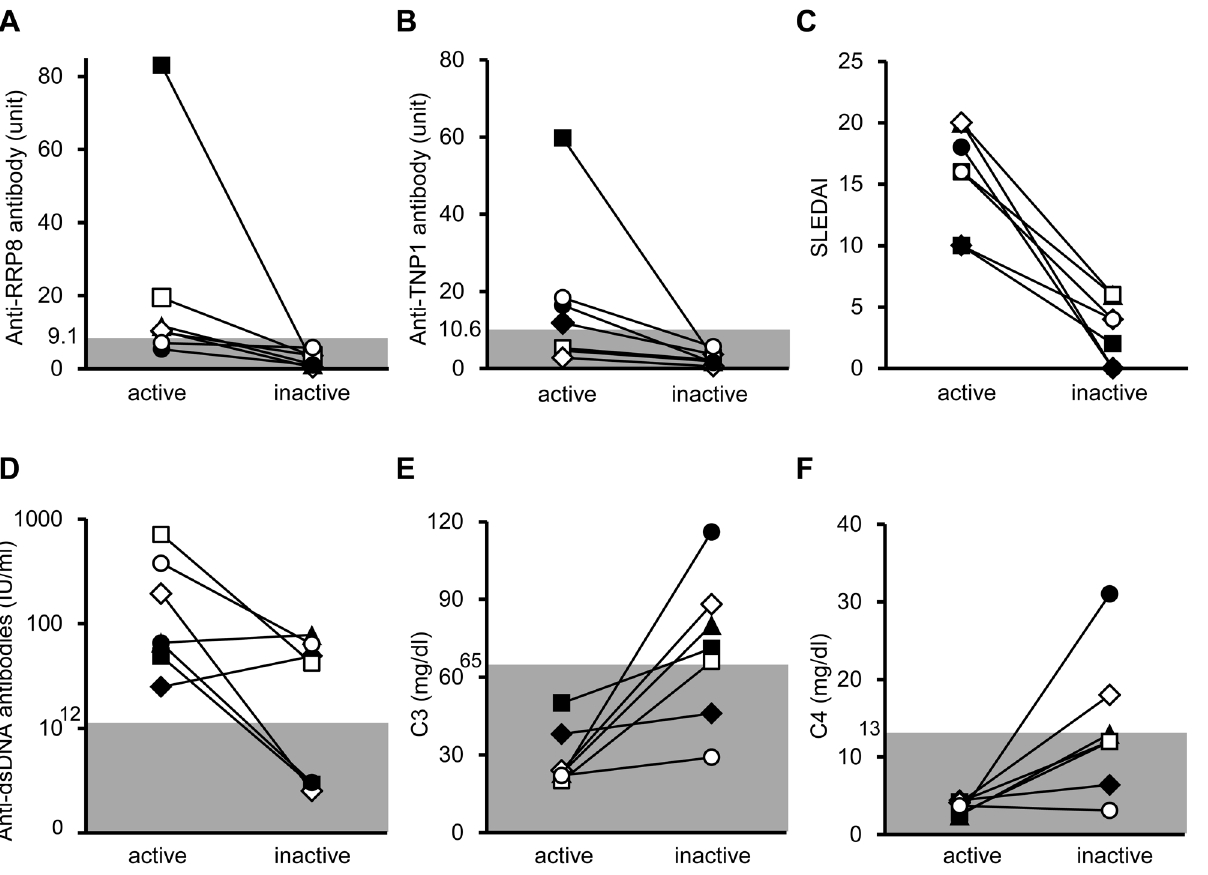
Fig 5. Changes in antibody levels and clinical findings in patients with lupus nephritis. ▲ LN1, ♦ LN2, ● LN3, ^ LN4, (cid:3) LN5, □ LN6, ■ LN7. (A) Anti- RRP8 antibody, (B) anti-TNP1 antibody, (C) SLEDAI, (D) anti-dsDNA antibody, (E) C3, and (F) C4. The active and inactive phases of LN were defined as 4 (cid:1) and 0 of the renal SLEDAI score,